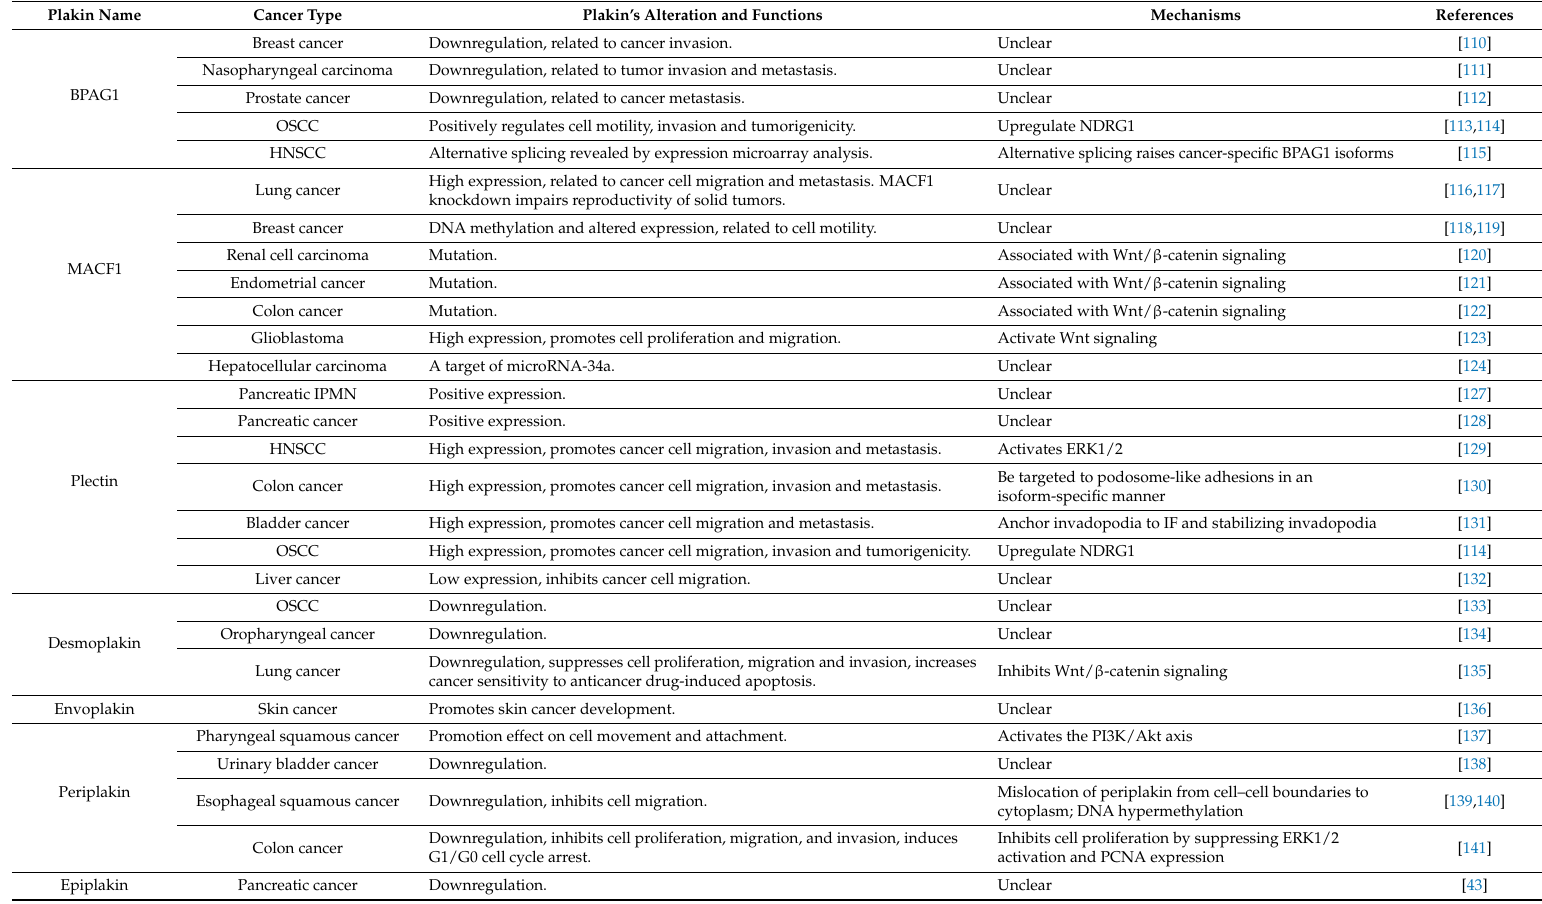
BPAG1: bullous pemphigoid antigen 1; OSCC: oral squamous cell carcinoma; NDRG1: N-Myc downstream regulated gene 1; HNSCC: head and neck squamous cell carcinoma; MACF1: microtubule actin crosslinking factor 1; Wnt: wingless and int-1; IPMN: intraductal papillary mucinous neoplasms; ERK1/2: extracellular signal-regulated kinases 1/2; IF: intermediate filament; PI3K: phosphatidylinositol 3 (cid:48) kinase; PCNA: proliferating cell nuclear